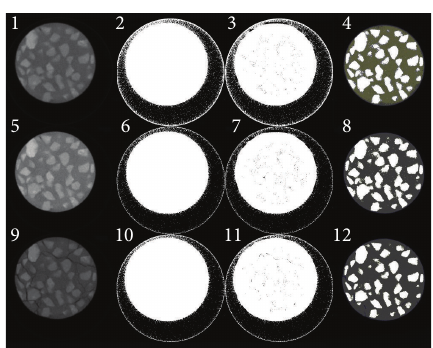
Figure6:PorosityextractionofRSAunderthreetypicalstresslevels using improved Ostu’s method (first line is 0MPa, Second line is 3.87 MPa, Third line is 6.33